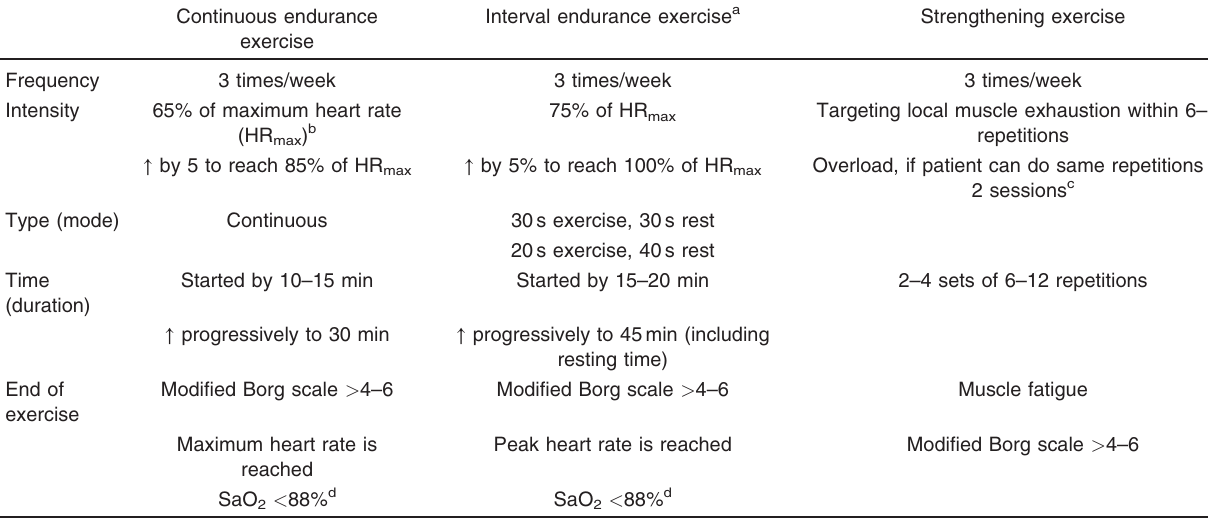
Table 1 Exercise training program